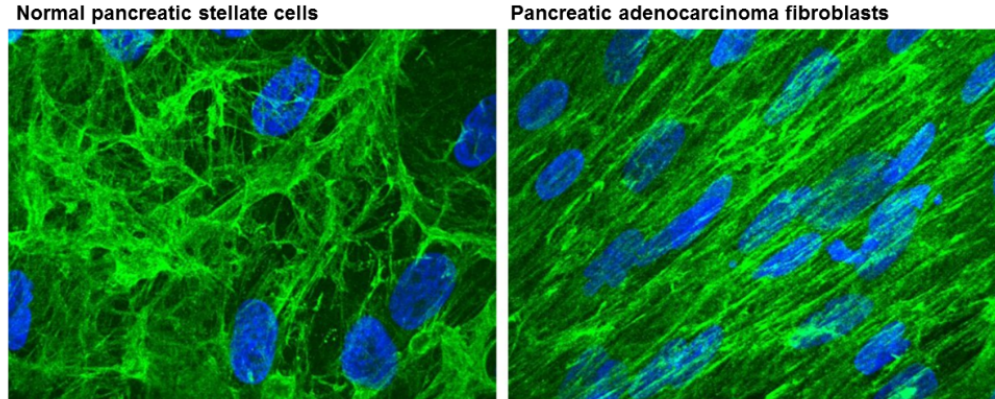
Figure 3. ECM fiber structures from normal pancreatic stellate cells and pancreatic adenocarcinoma associated fibroblasts stained for anti-fibronectin (green). ECMs organized in parallel patterns were observed in pancreatic adenocarcinoma fibroblasts that are similar to those formed by FAP-positive matrices. In contrast, ECM structures of normal pancreatic stellate cells resemble more FAP-negative matrices. Nuclei were stained with DAPI (blue). Reproduced with permission from [39].